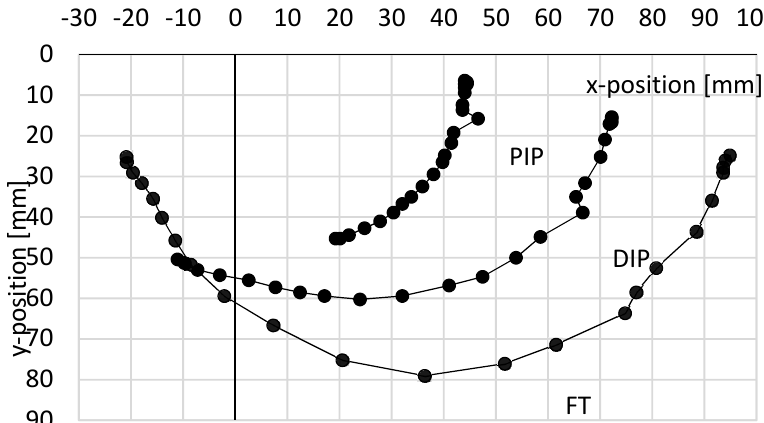
Figure 4. Acquired trajectories of PIP, DIP, and FT markers (as in the set-up of Figure 1 for the finger movement of a healthy human (dots indicate the measured data from the video capture tracking).